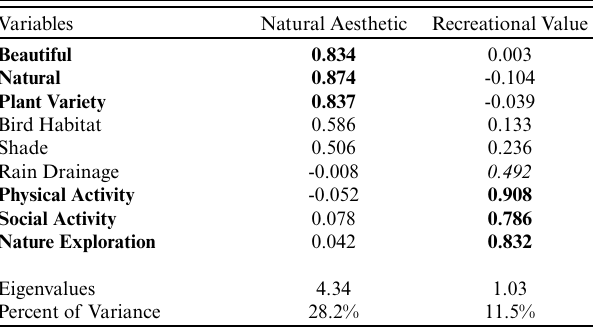
Table 2 . Pattern matrix (loadings) from factor analysis of ecosystem service variables. The variables and their significant loadings for each factor are in bold.